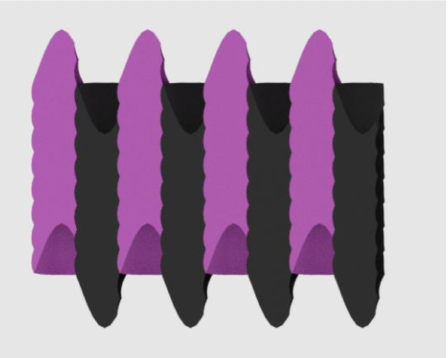
Figure 8. The model of a single layer (colors indicate the change in laser direction).